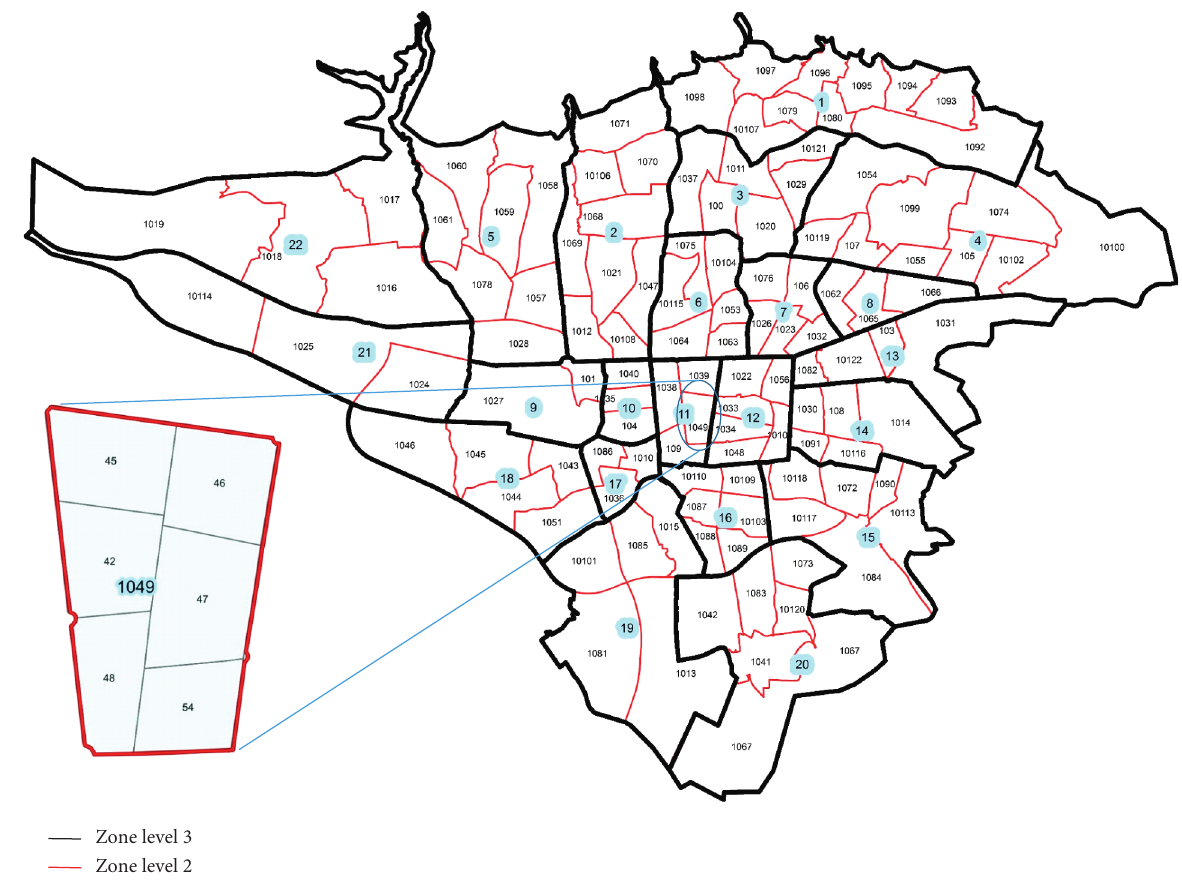
Figure 6: Zoning levels of Tehran.